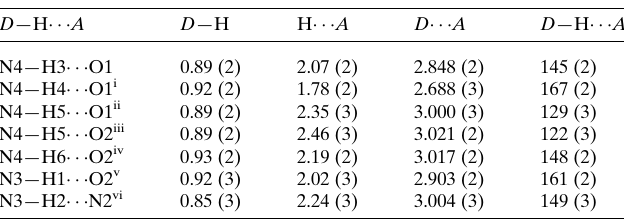
Table 1 Hydrogen-bond geometry (A˚ , (cid:4) ).